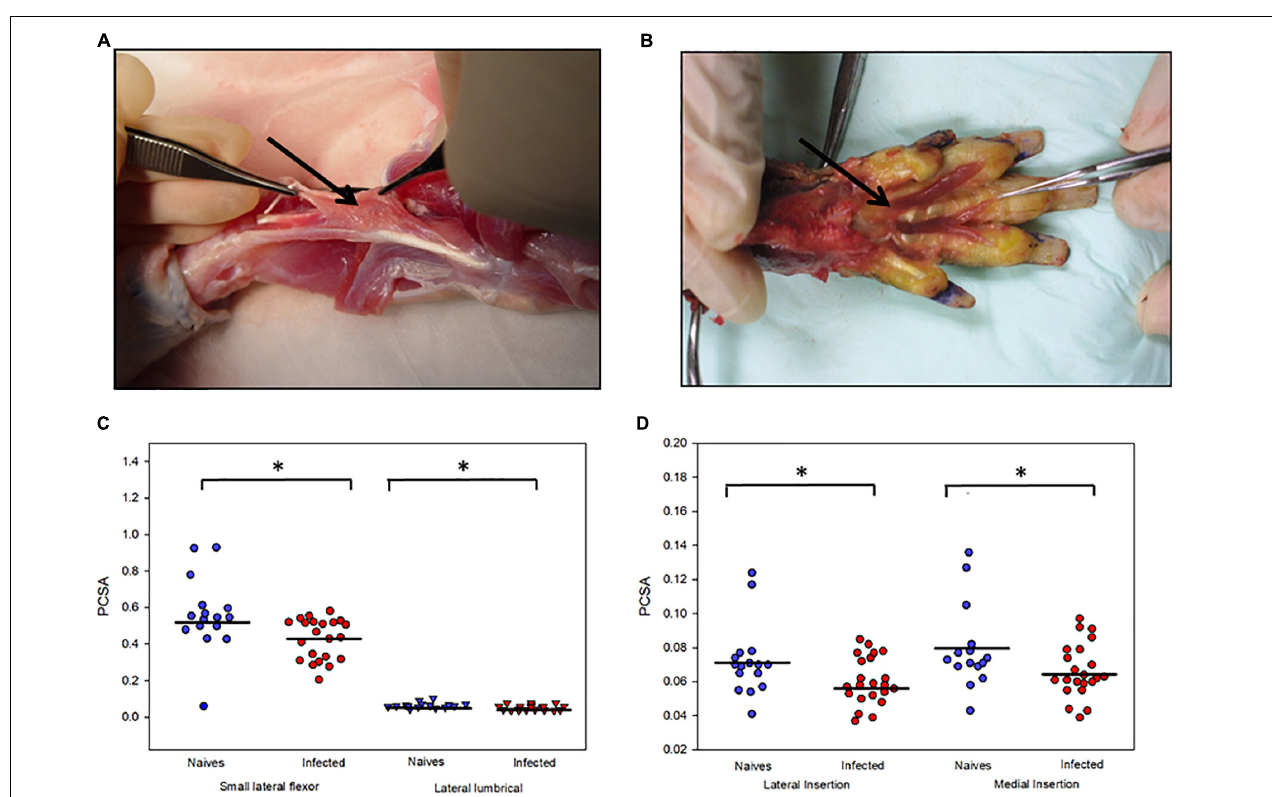
FIGURE 6 | M. leprae infection causes atrophy of armadillo footpad muscles. Photographs of the dissection of a representative animal showing (A) the small lateral flexor muscle of the footpad and how the fibers run between the tendons and (B) the lumbrical muscles of the right hind limb that were released from their tendon of insertion. (C) Atrophy of small lateral flexor and lateral lumbrical muscles in M. leprae- infected armadillos compared to uninfected armadillos. (D) Atrophy of medial and lateral insertions of the medial lumbrical muscle in M. leprae- infected armadillos ( N = 10) compared to uninfected armadillos ( N = 8). ∗ p < 0.05.